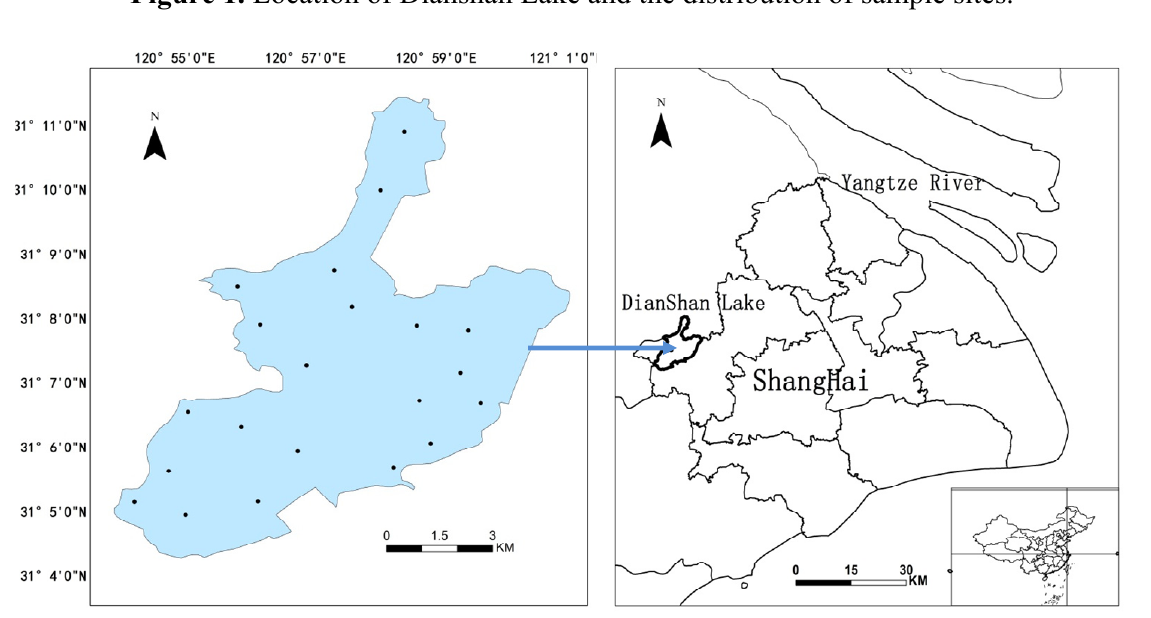
Figure 1. Location of Dianshan Lake and the distribution of sample